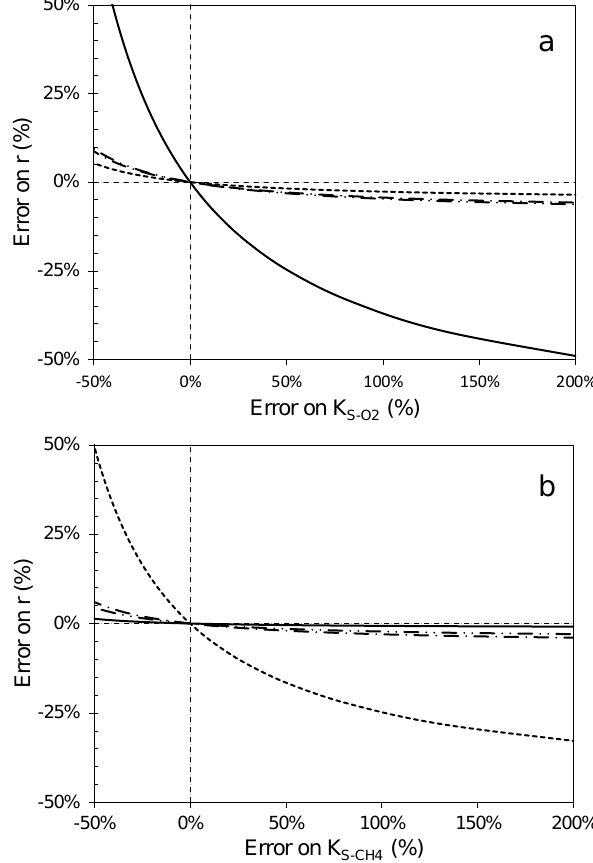
Figure 6. Sensitivity analysis of the impact of an error or variation in K S − O (a) and K S − CH (b) on r ; yedoma lakes in winter (–), 2 4 yedoma lakes in summer (– · – · ), non-yedoma lakes in winter (– ·· – ·· ) and non-yedoma lakes in summer